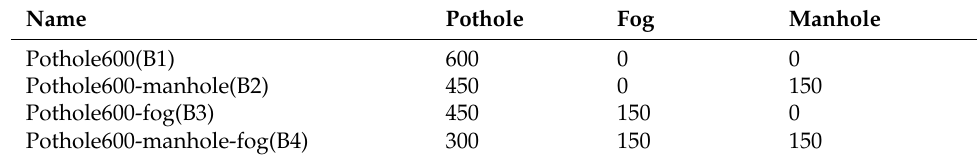
Table 2. Number of photos of each type in B1, B2, B3, B4 of pothole600 dataset.